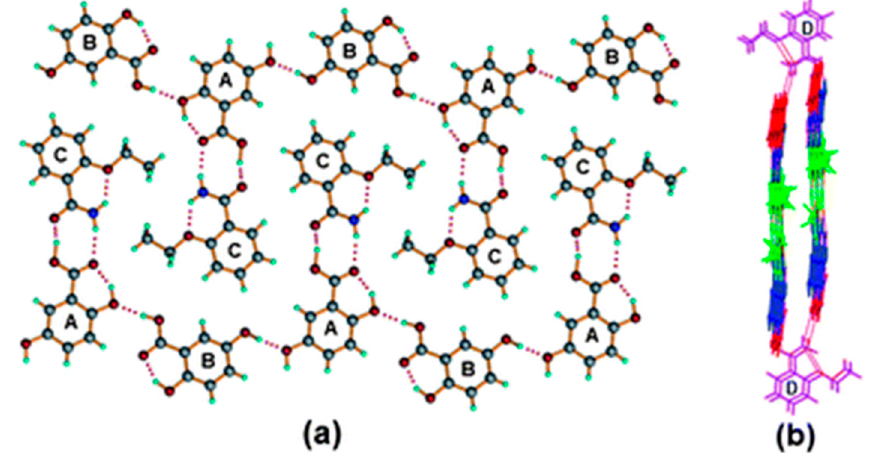
Figure 20. ( a ) A zipper like structure in EA:GA cocrystal Form I. ( b ) 3D crystal packing showing the